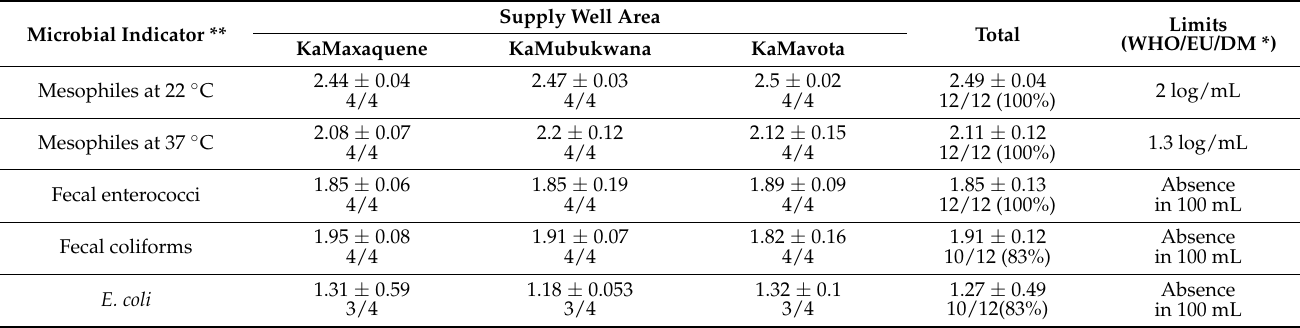
Table 4. Evaluation of water from supply wells in three municipal districts of Maputo, according to each microbial indicator for drinking water. Number of samples with contamination higher than the limits and total percentage (%) are indicated.